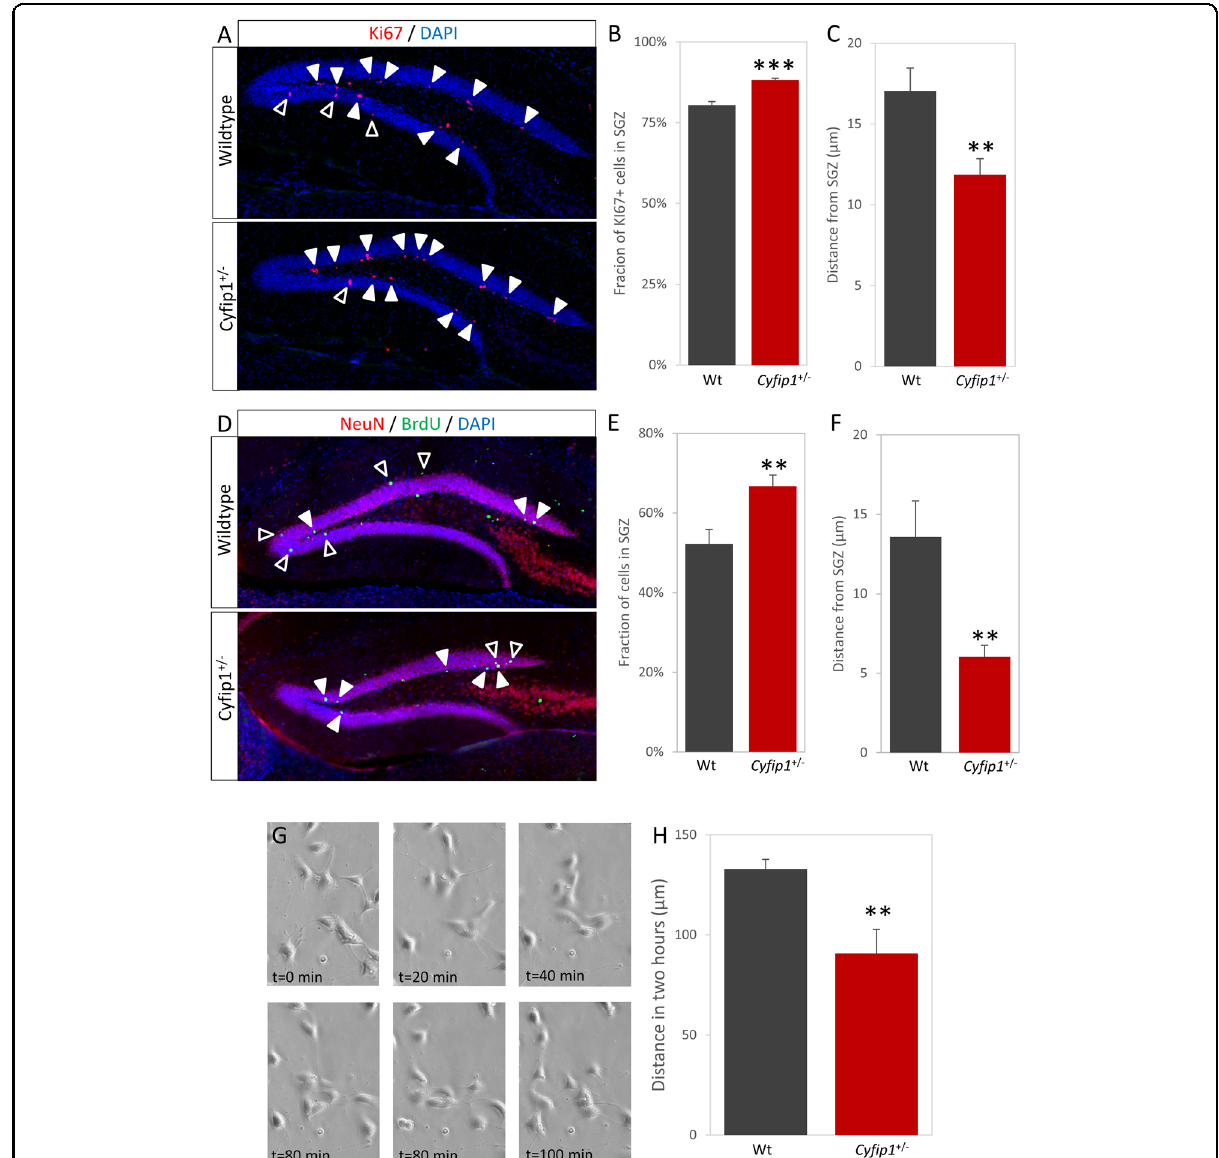
Fig. 4 Altered migration of immature Cy fi p1 + / − neurons. A Immunohistochemistry for the Ki67, showing cells in the cell cycle, shows the majority are located in the SGZ (closed arrowheads), but some are starting to move out into the granular layer (open arrowheads). B A signi fi cantly larger fraction of Ki67 + cells are located in the SGZ in Cy fi p1 + / − animals, comparted to wild types. C The distance moved from the SGZ is signi fi cantly lower in the Cy fi p1 + / − animals, comparted to wild types. D Post-mitotic adult-born neurons (NeuN + /BrdU + ) are located predominantly in the granular layer (open arrowheads), but some are still located in or near the SGZ (closed arrowheads). E As with Ki67 + cells, a smaller fraction of Cy fi p1 + / − cells are in the granular layer. F Distance moved by these cells is signi fi cantly lower. G Time-lapse imagining shows the movement of cells in primary hippocampal cultures. H Quanti fi cation of cell movement during live imaging shows a signi fi cantly smaller distance moved by the Cy fi p1 + / −